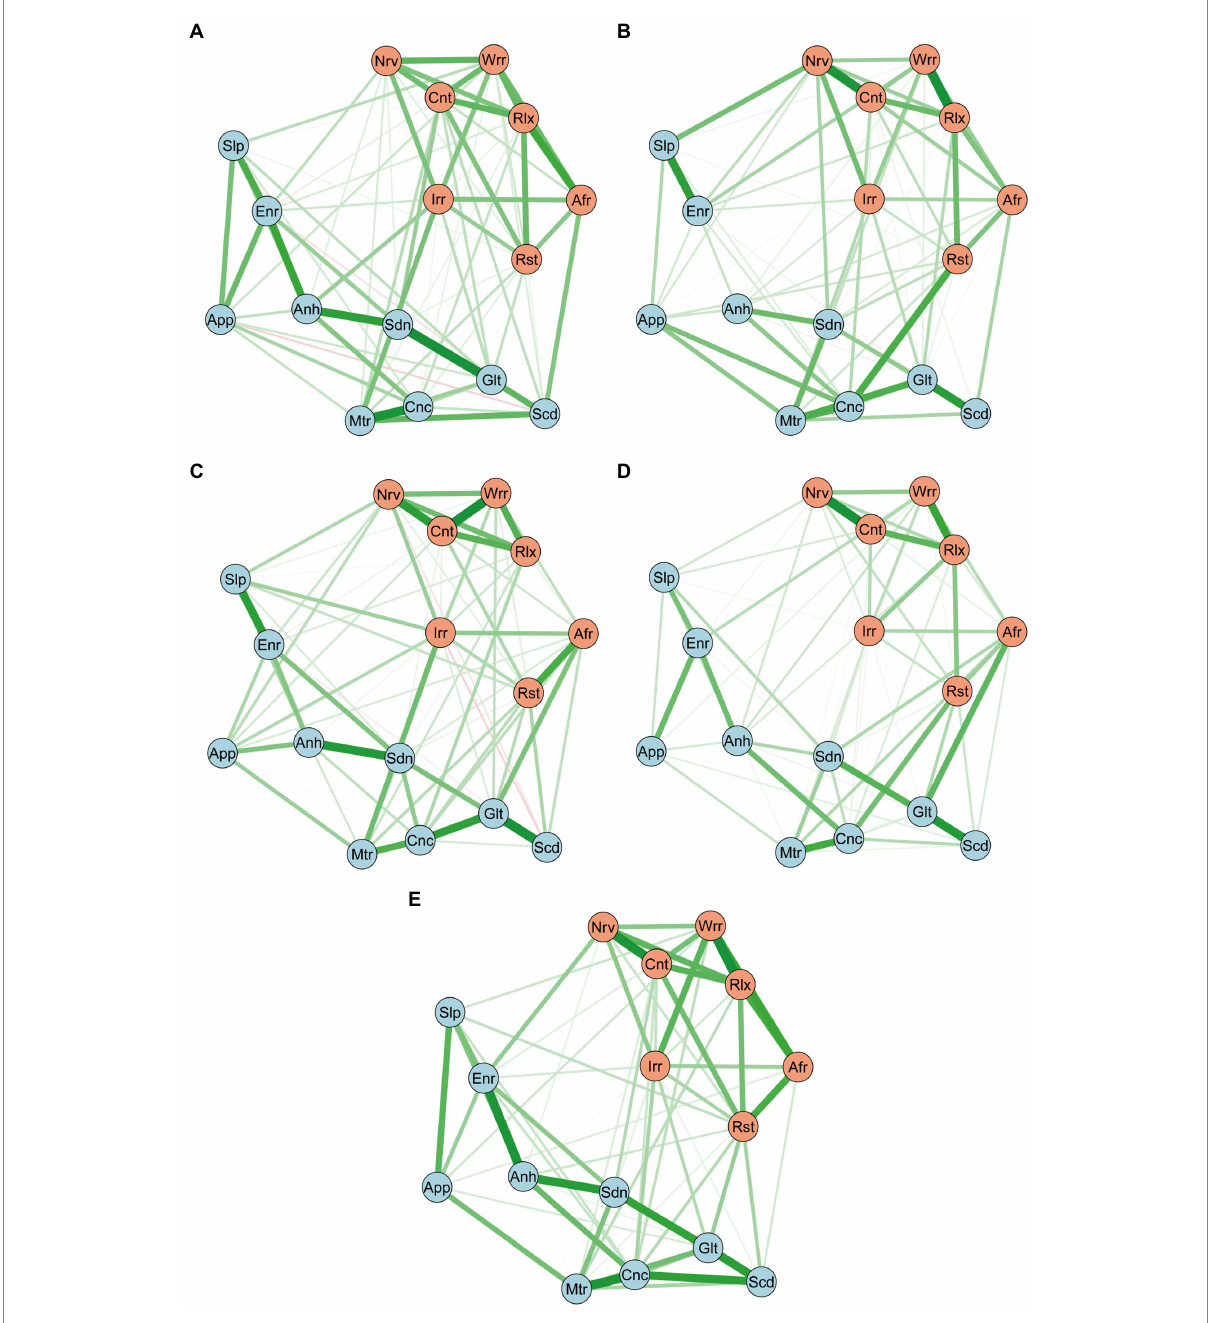
FIGURE 1 Networks of Depression/anxiety Symptoms at T1 ( A ; n = 343), at T2 ( B ; n = 269), at T3 ( C ; n = 261), at T4 ( D ; n = 212), and T1-T4 Slopes Network ( E ; n = 210). The blue nodes indicate the PHQ-9 items, and the orange nodes indicate the GAD-7 items. Positive edges appear green, negative red, and stronger and saturated edges represent strong regularized partial correlations. Anh, Anhedonia; Sdn, Sadness; Slp, Sleep; Enr, Energy; App, Appetite; Glt, Guilty; Cnc, Concentration; Mtr, Motor; Scd, Suicide; Nrv, Nervous; Cnt, Control; Wrr, Worry; Rlx, Relax; Rst, Restless; Irr, Irritable; Afr, Afraid; PHQ-9, Patient Health Questionnaire-9; GAD-7, Generalized Anxiety